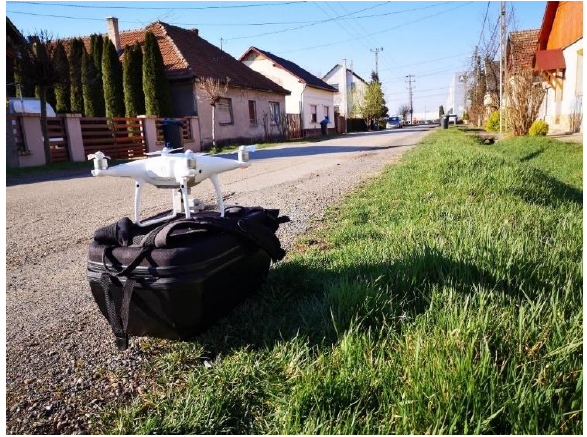
Figure 12 . DJI Phantom 4 Pro before taking off at Üllő.